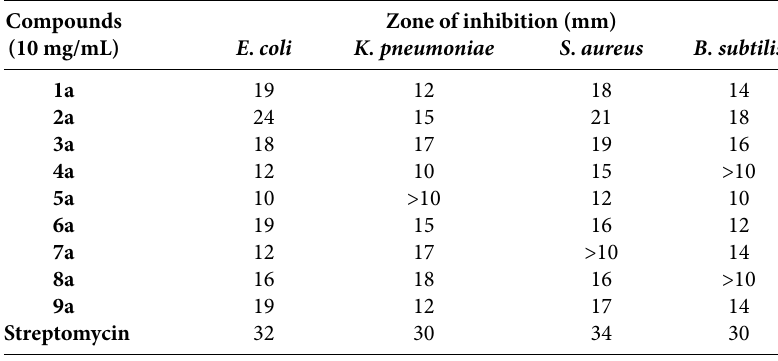
Table 2. Zone of inhibition values (mm) of the synthesised compounds Compounds